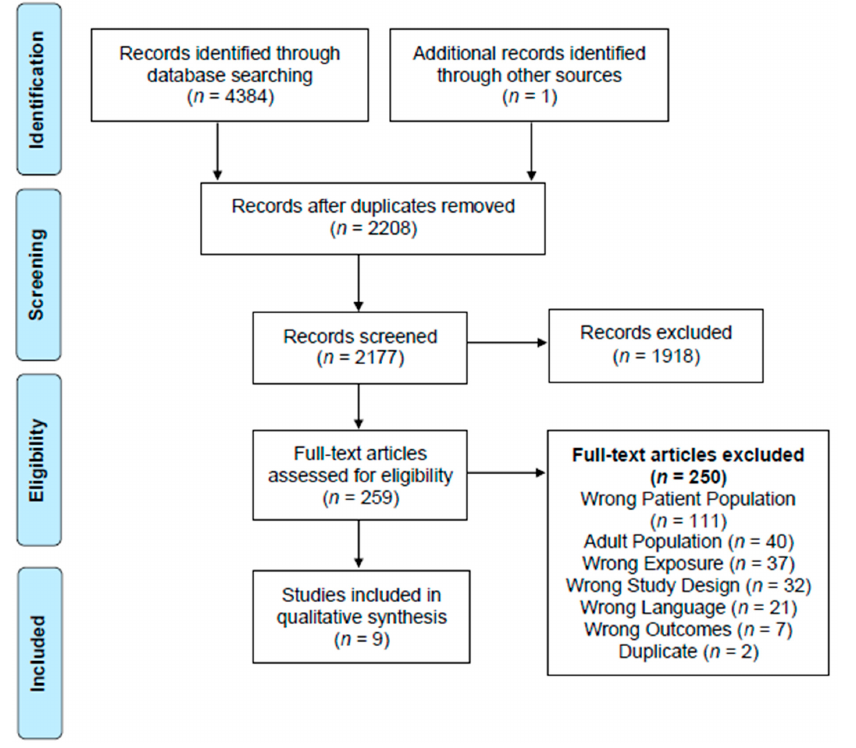
Figure 1. PRISMA Flow Diagram.